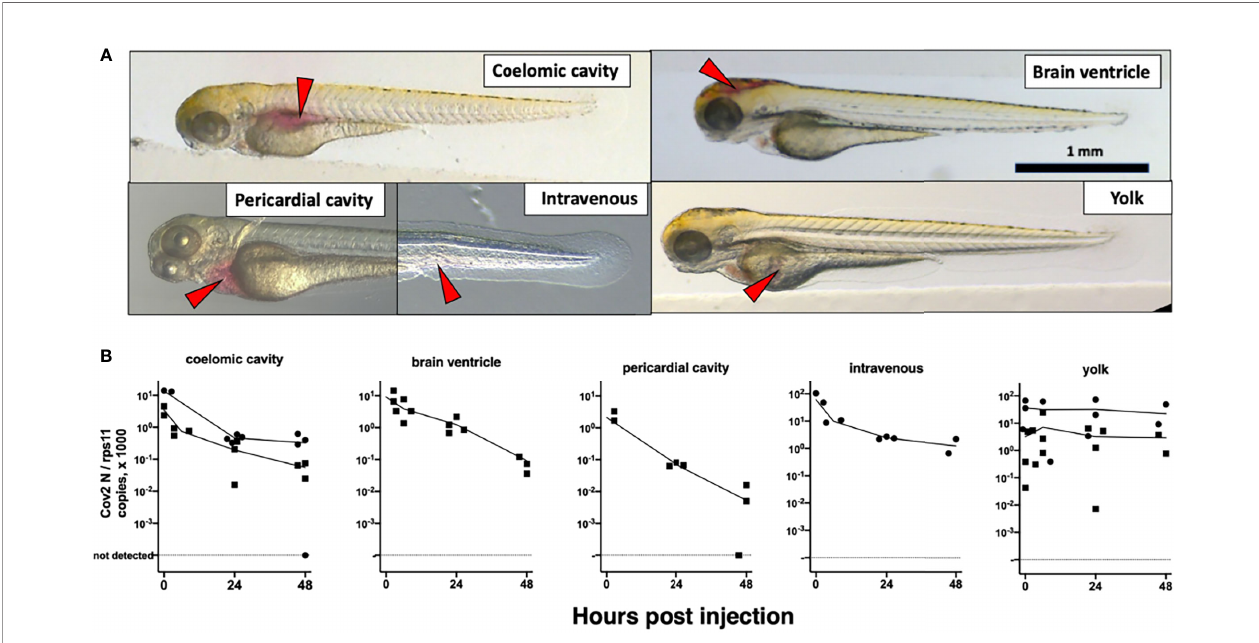
FIGURE 2 | Microinjection of SARS-CoV-2 to 3-dpf wild-type larvae. (A) Illustrations of the targeted sites. Images taken less than 1 min after injection of the phenol red-colored SARS-CoV-2 suspension. Red arrowheads point to the sites of microinjection. (B) Quanti fi cation of polyadenylated N transcripts over time, assessed by qRT-PCR; each symbol is an individual larva. Circles and squares correspond to injection of viral suspensions 1 and 2, as labeled on Table 1 , respectively. Lines connect the means of values measured at each time point.